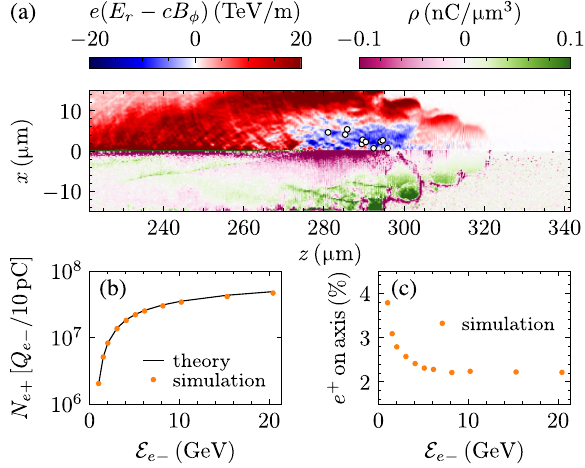
FIG. 2. Positron guiding and injection. (a) Electron beam loading after 280 μ m of propagation. Upper panel: channel fields contribution to the transverse Lorentz force on the positrons ( m ¼ 0 ). Lower panel: net plasma charge density. (b) The number of generated positrons; (c) The fraction of positrons injected in the laser propagation direction as a function of the electron beam energy for a laser field amplitude 5 × 10 23 W = cm 2 (circles). Panel (b) shows the number of positrons generated using an electron beam of 10 pC and can be directly scaled to different beams (e.g., Q e − ¼ 100 pC would give 10 times more